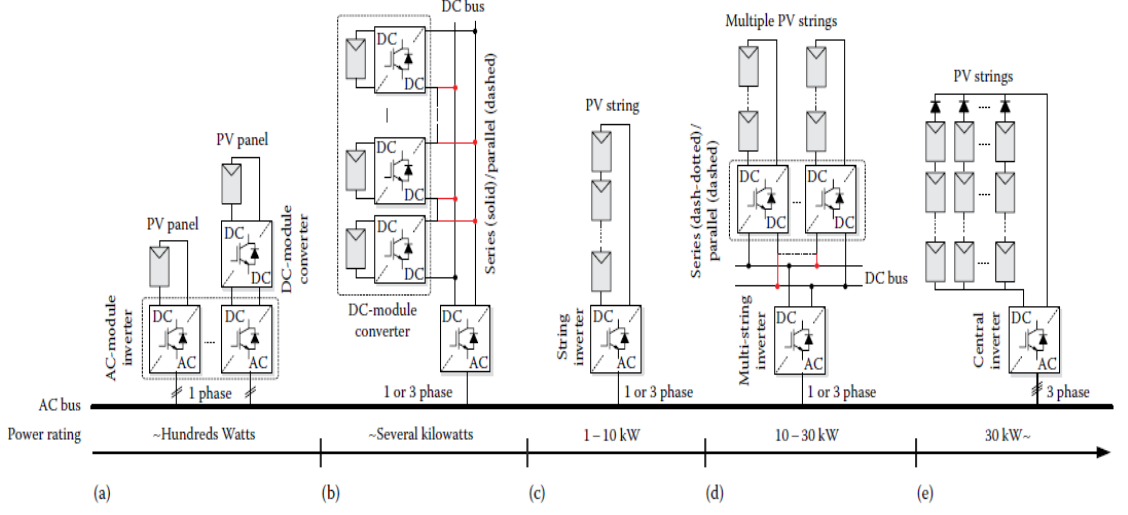
Figure 1. Power converter technology for PV system: ( a ) Residential/small systems, ( b ) residential/small systems, ( c ) residential, ( d ) residential /commercial, and ( e ) utility-scale/commercial PV applications [29].